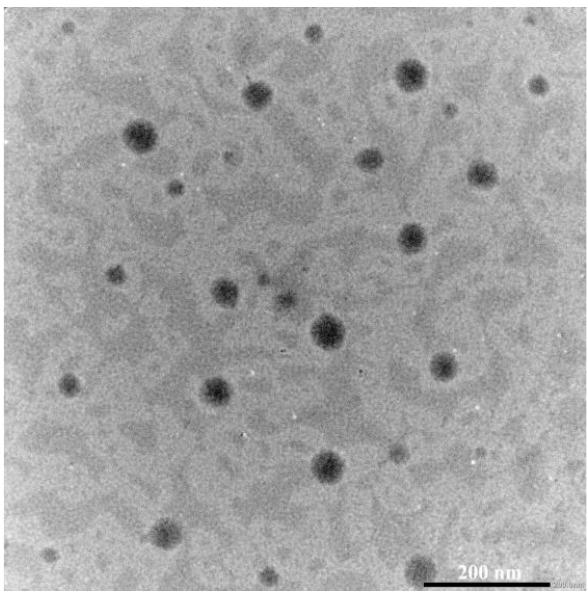
Figure 6. TEM image of the CH microemulsion.